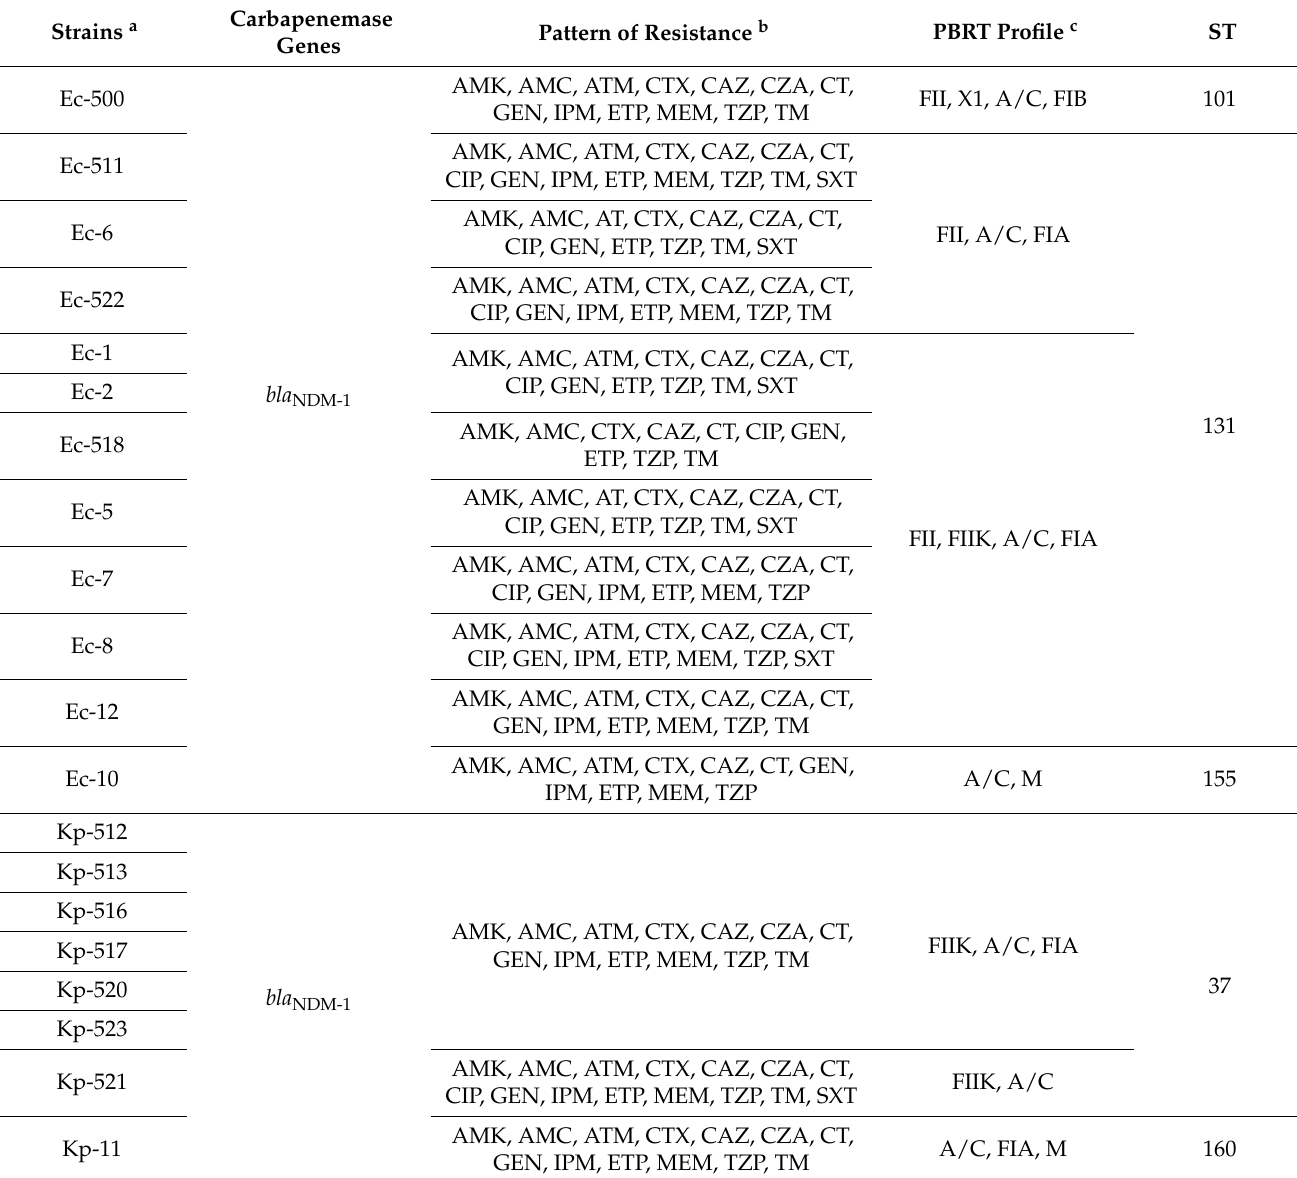
Table 2. Genotypic and phenotypic profiles of strains isolated from neonatal